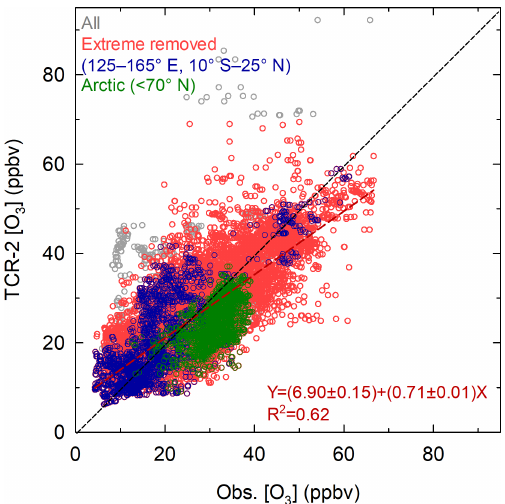
Figure 5. Scatterplot of observed and reanalysis O 3 mixing ratios. Gray circles include all data ( N = 11666), red circles are cases in which data from MR14-01 and extreme cases in which TCR-2 exceeded 70ppbv were removed. Green circles indicate data from Arctic region (>70 ◦ N) and blue circles indicate data from domain 2 (125–165 ◦ E, 10 ◦ S to 25 ◦